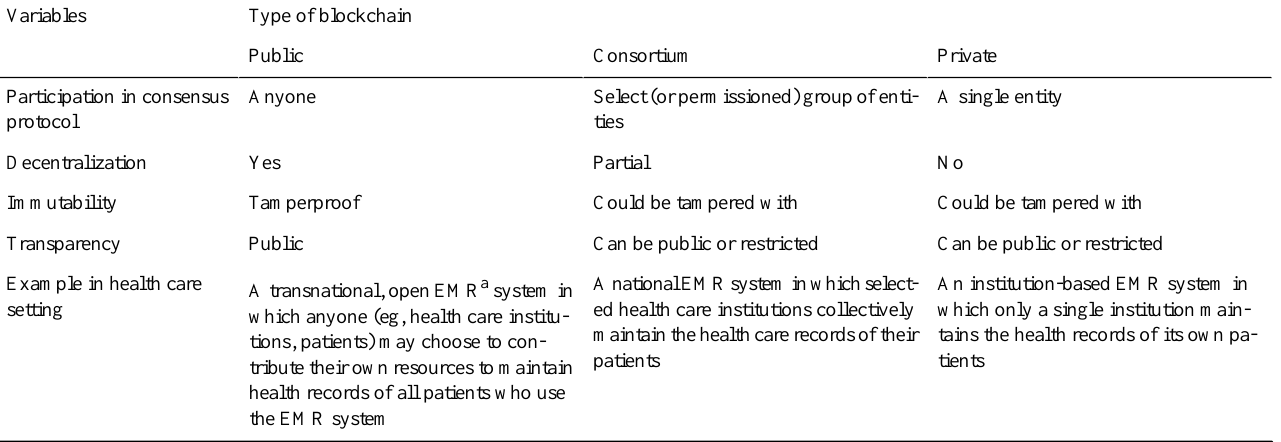
Table 1. Comparison of public, consortium, and private blockchains. Type of